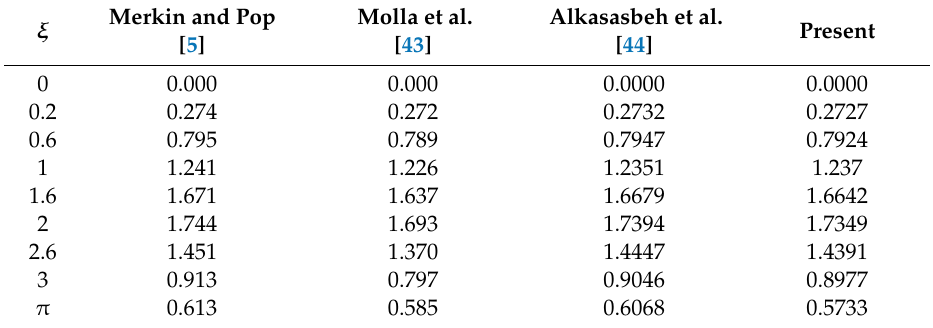
Comparison of the current findings Gr 1/5 C f with prior published findings, at Pr = 1, χ = 0, M = 0, and γ → ∞ .